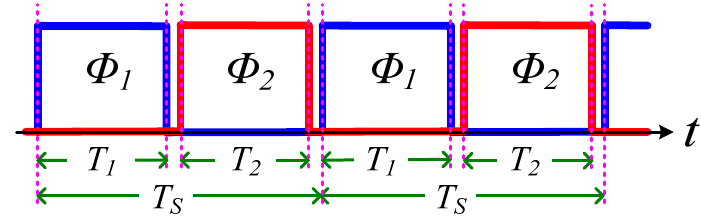
Figure 2. Time slots of the proposed voltage equalization system.